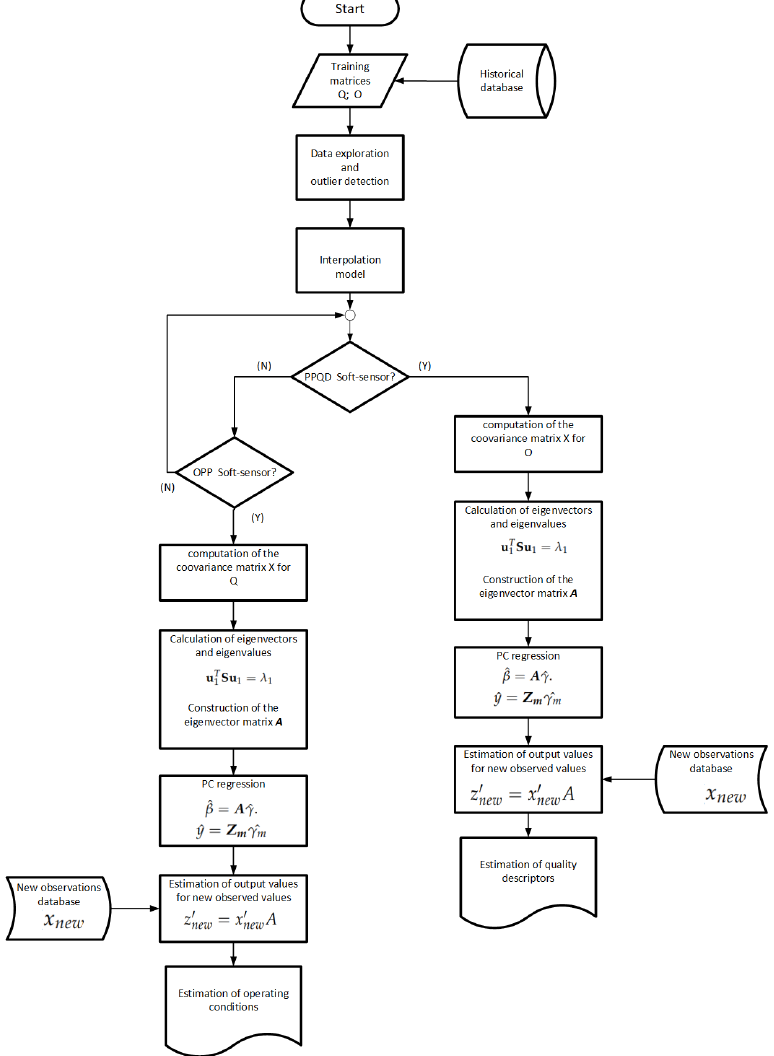
Figure 23. Flow chart stages of the proposed soft sensor to obtain estimates of the quality descriptors and the operating